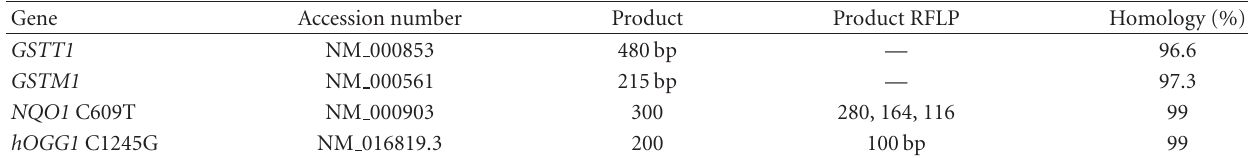
Table 2: Summary of accession number of individual genes and their products sequenced after purification with percentage homology.